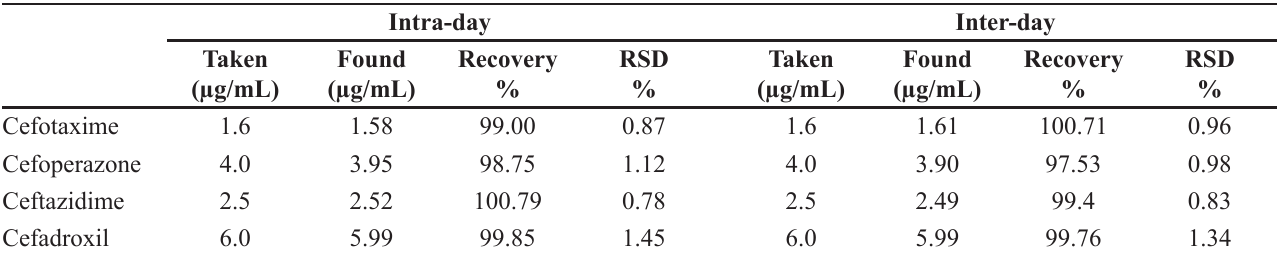
TABLE VIII - The intra-day and inter-day accuracy and precision data for the determination of cefotaxime, cefoperazone, ceftazidime and cefadroxil through silver nanoparticles